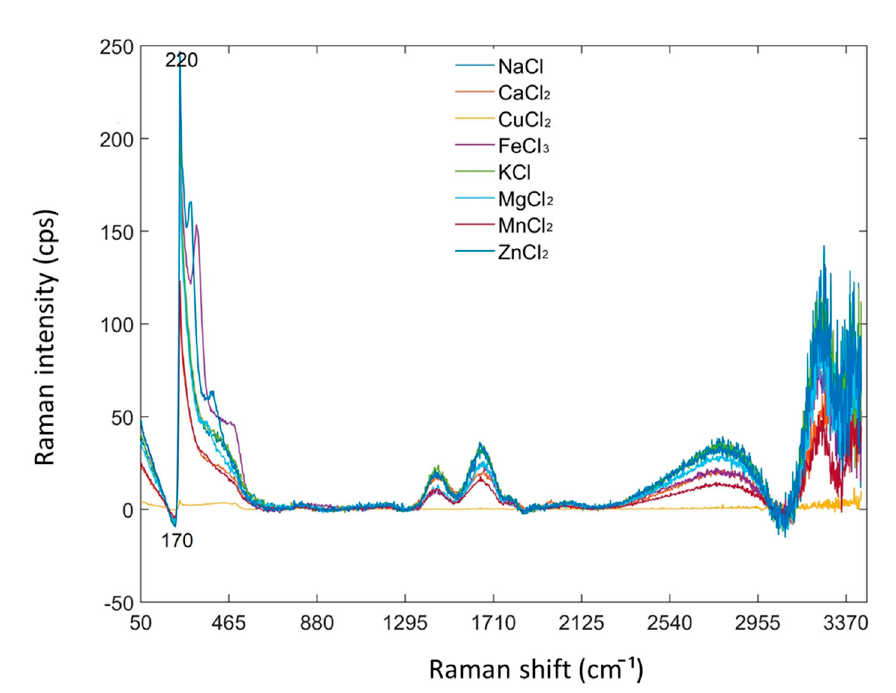
Figure 4. Raman spectra of chloride salt solutions pre-treated by AsLs baseline correction.